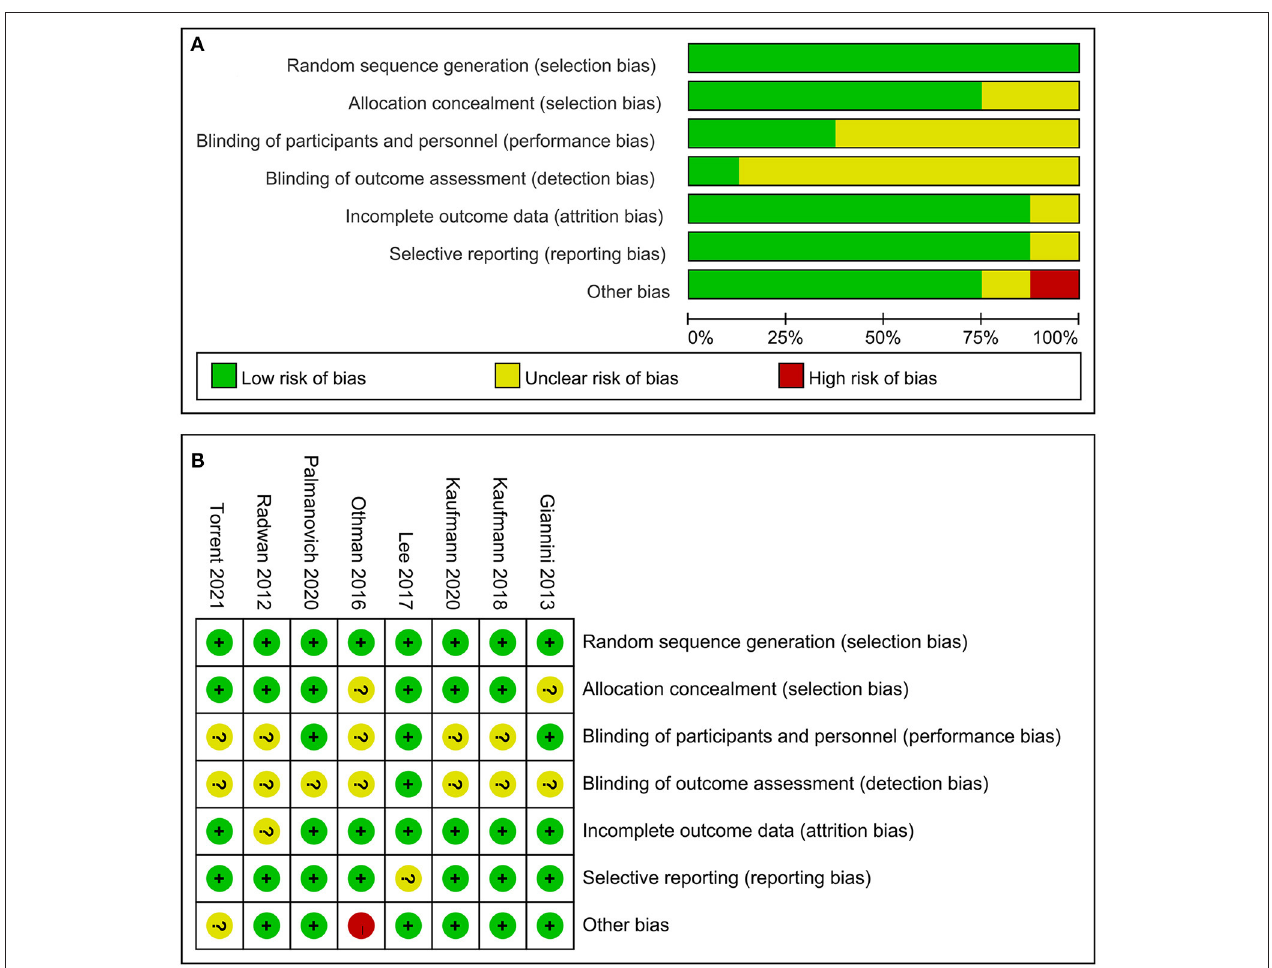
FIGURE 2 | Quality assessment for randomized controlled trials (RCTs). (A) Risk of bias summary and (B) risk of bias